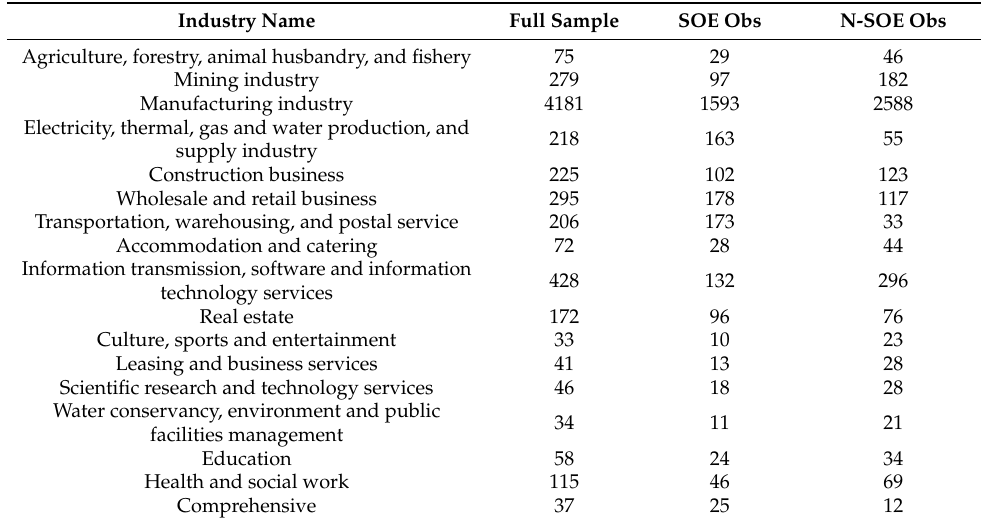
Table A1. Sample Distribution by Industry ( N =